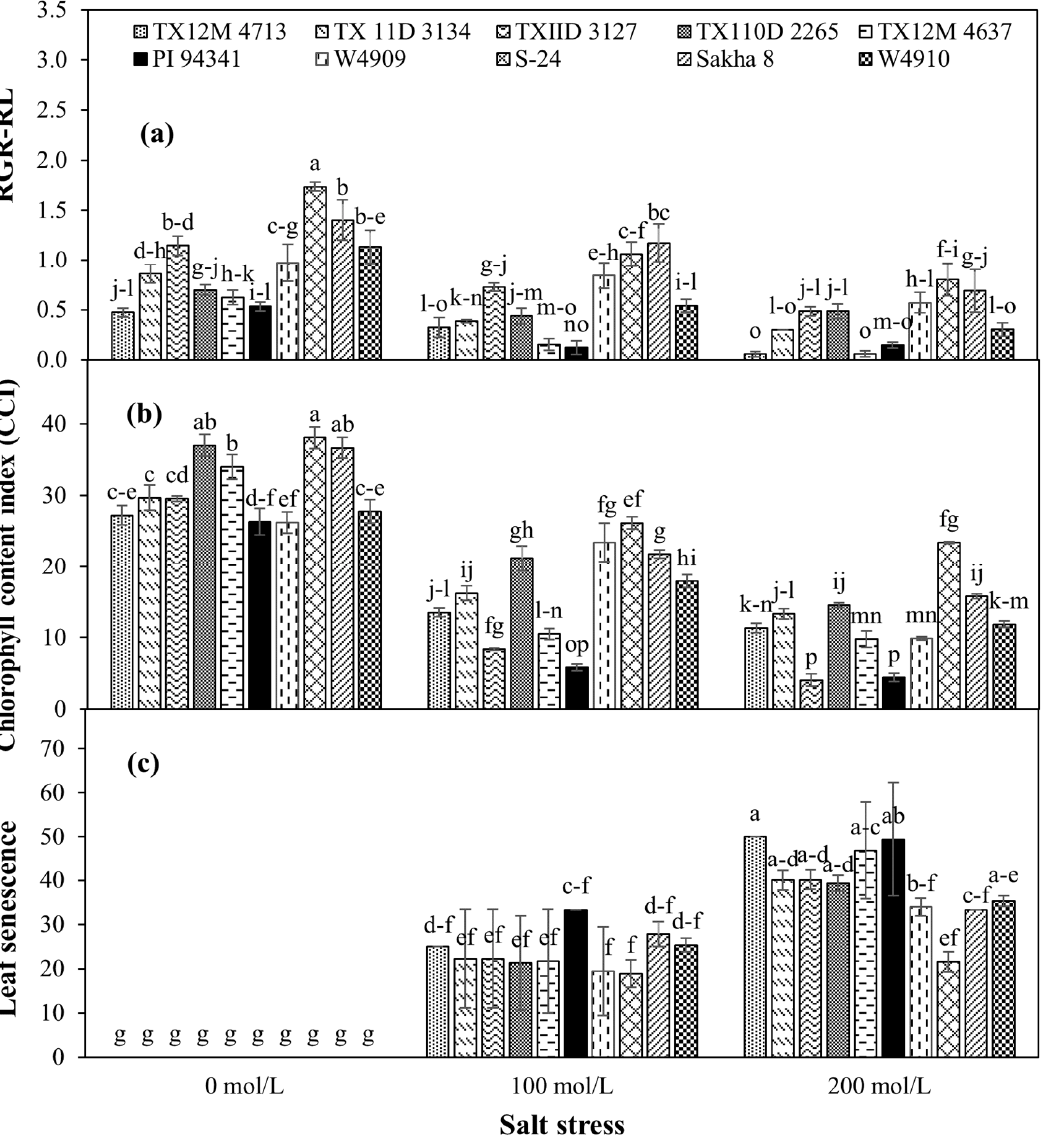
Figure 4. Influence of salt stress on ( a ) relative growth rate of root length (RGR-RL), ( b ) chlorophyll content index (CCI), and ( c ) senescence of leaves of wheat genotypes. Error bars indicate S.E. ( n = 3 ). Different letters above the bars represent significant differences at the p < 0.05.